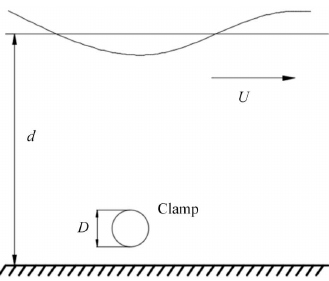
Figure 8. Placing the clamp horizontally (the wave current direction is the clamp axial direction).